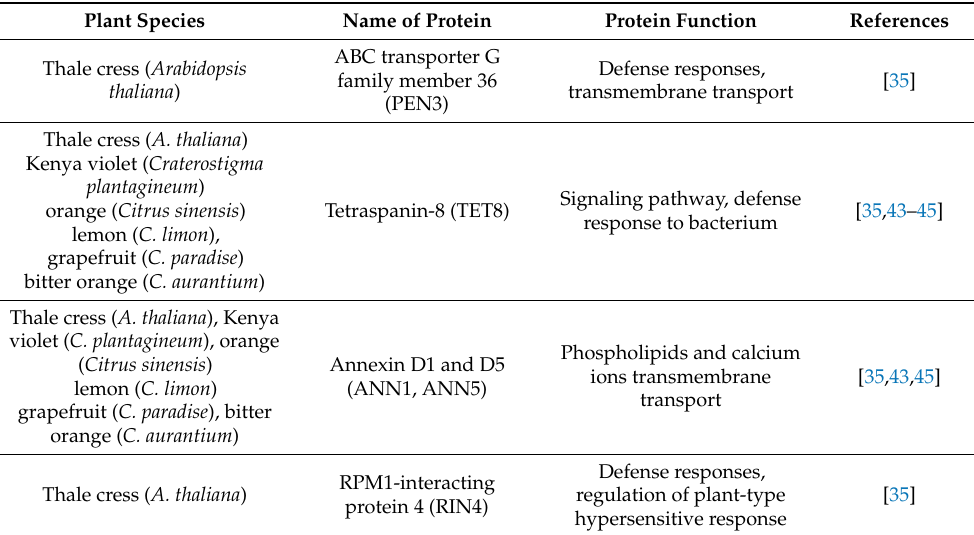
Table 1. Protein components of plant